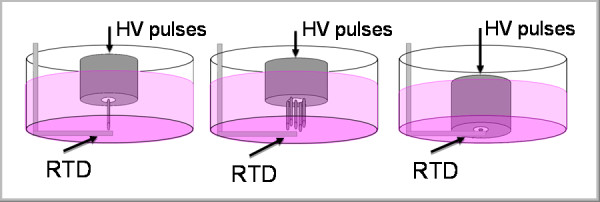
Temperature measurement setups at the tips of single-needle, five-needle array, and flat-cut cable electrodes powered with continuous electric pulses (10 kV, 15 ns @ 50 Hz).